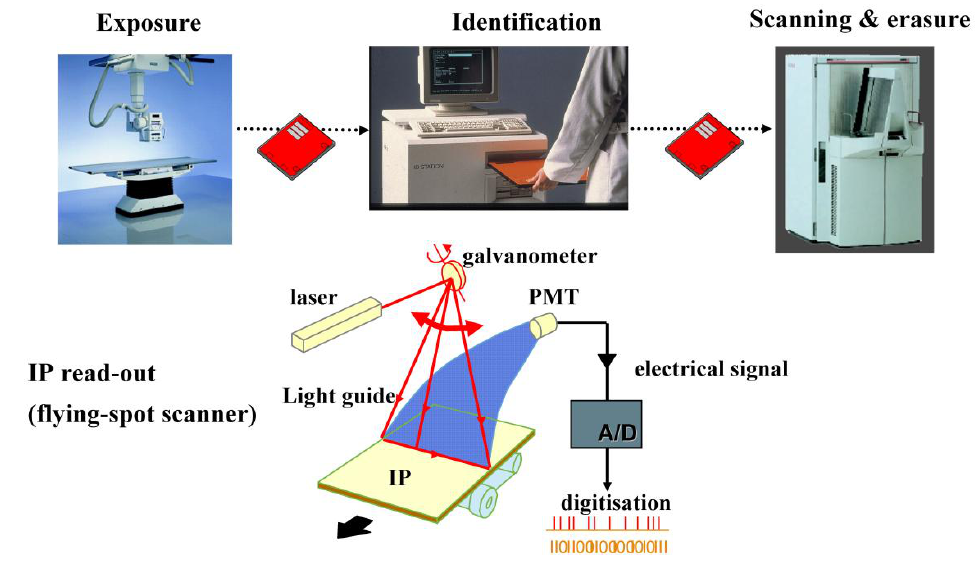
Figure 4. CR storage phosphor plate exposure and